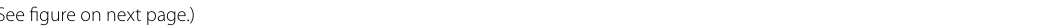
figure on next Fig. 3 Effects of exogenous Put and d -arg on the POX ( a ), CAT ( b ) and SOD ( c ) activities in the leaves of anthurium seedlings under chilling stress. Seedlings were treated with normal temperature, chilling (control), 0.5 mM Put Put chilling or 1.0 mM d -arg chilling for 3 days and a recovery for 1 day, and activities of POX, CAT and SOD in the leaves were assayed. Each + + point represents the mean SE ( n 5). Treatments marked with different letters at a given sampling date are significantly different at P < ± =